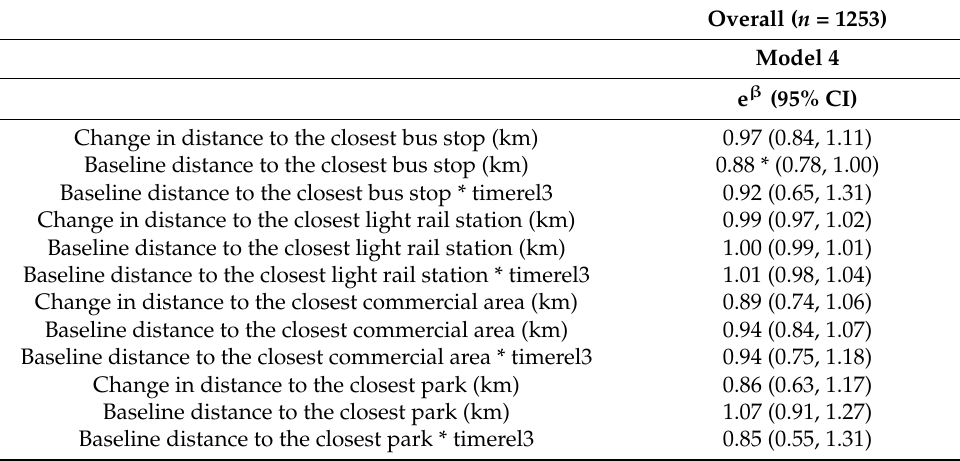
Table A3. Results for fully adjusted model without insignificant covariates.